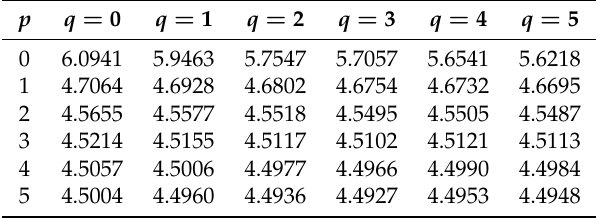
Table A7. Bit rates (bits/pixels) obtained for various values of p and q , on “Gualtar”.